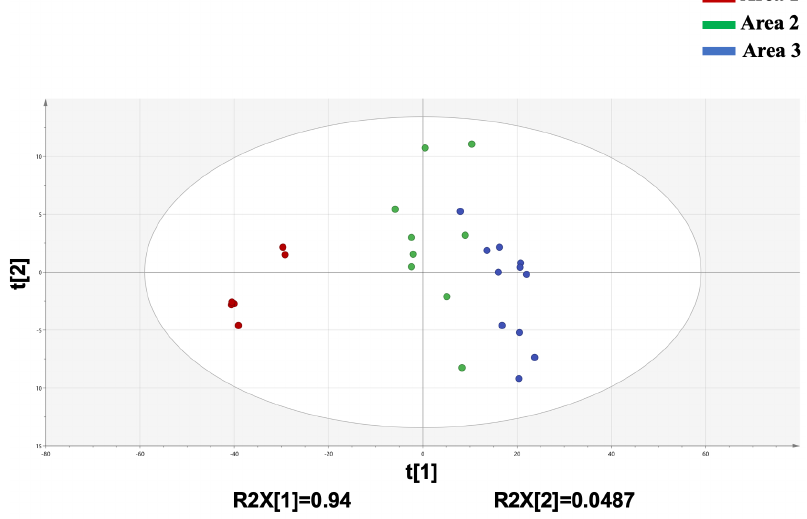
Figure 5. Score plot of PCA of 26 samples of RAL from different regions.